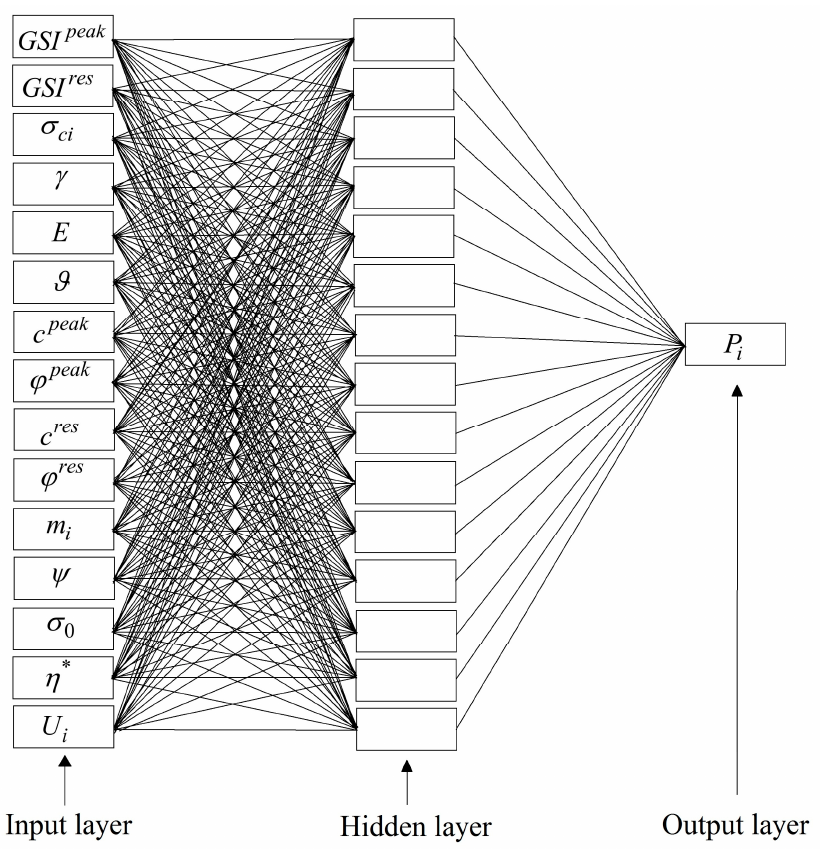
Figure 2. The topology of the optimum RBF-ANN (15-15-1) developed for the prediction of the P i (Mohr–Coulomb criterion).